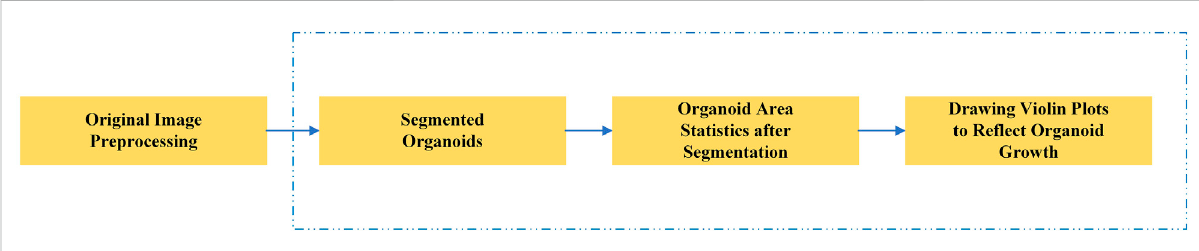
FIGURE 1 Main steps of the automated drug screening assessment in organoids. The steps in the blue dotted line show the traditional, manual method, while in our method these steps are performed automatically by the